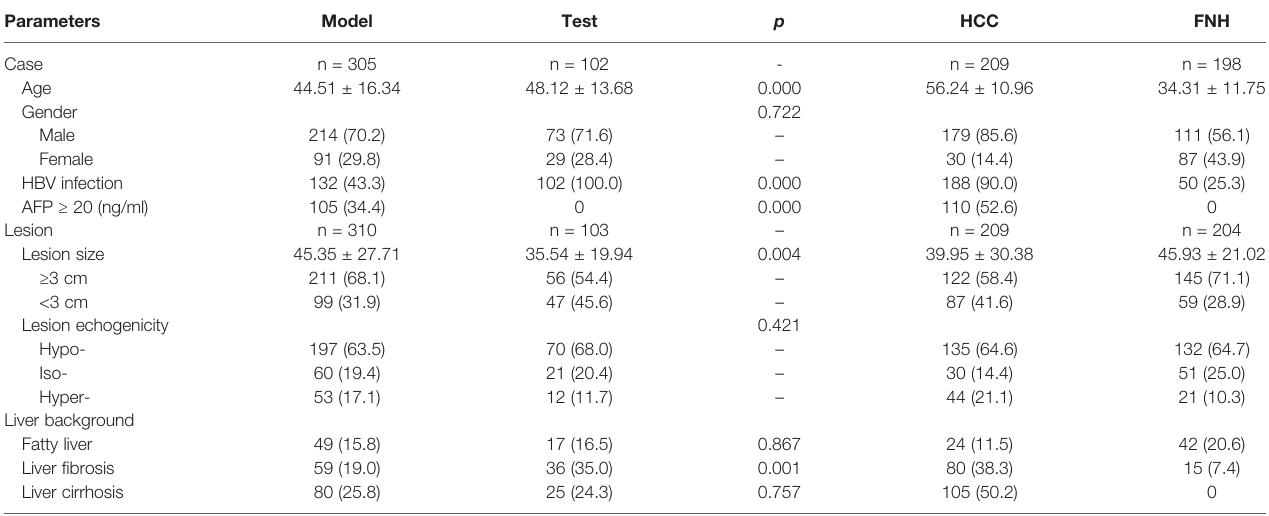
TABLE 1 | Baseline information in the model and test cohorts. Parameters